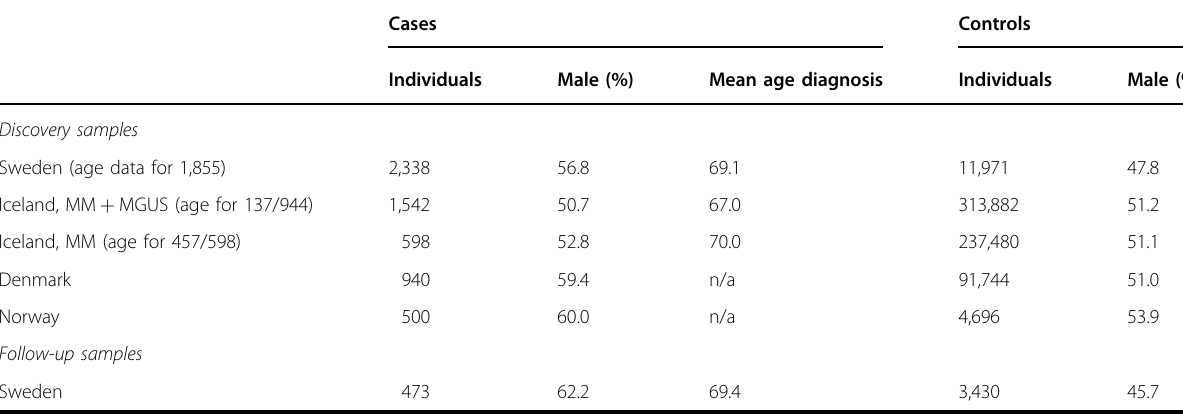
Table 2 Characteristics of study